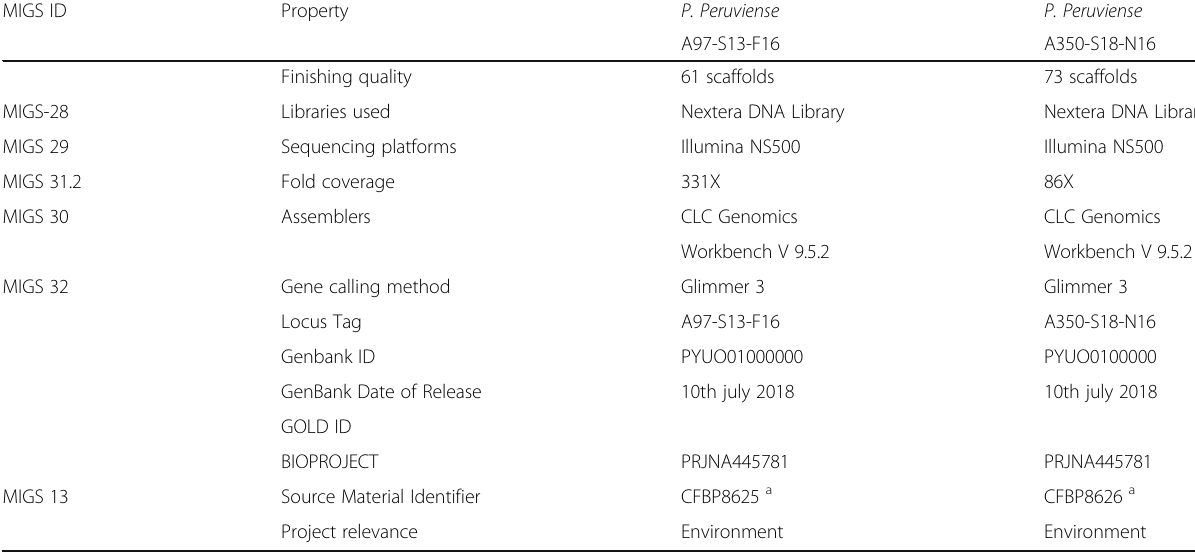
Table 2 Genome sequencing project